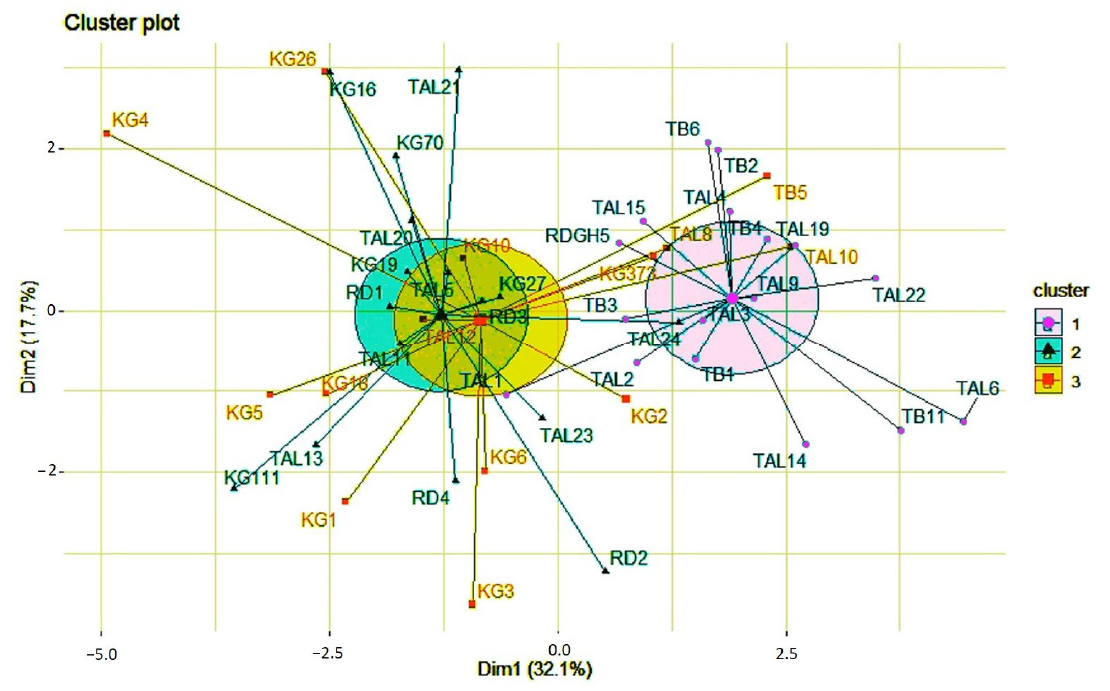
Figure 5. Principal Components Analysis (PCA) via distance matrix of 47 walnut genotypes from populations within Hamedan, Iran.